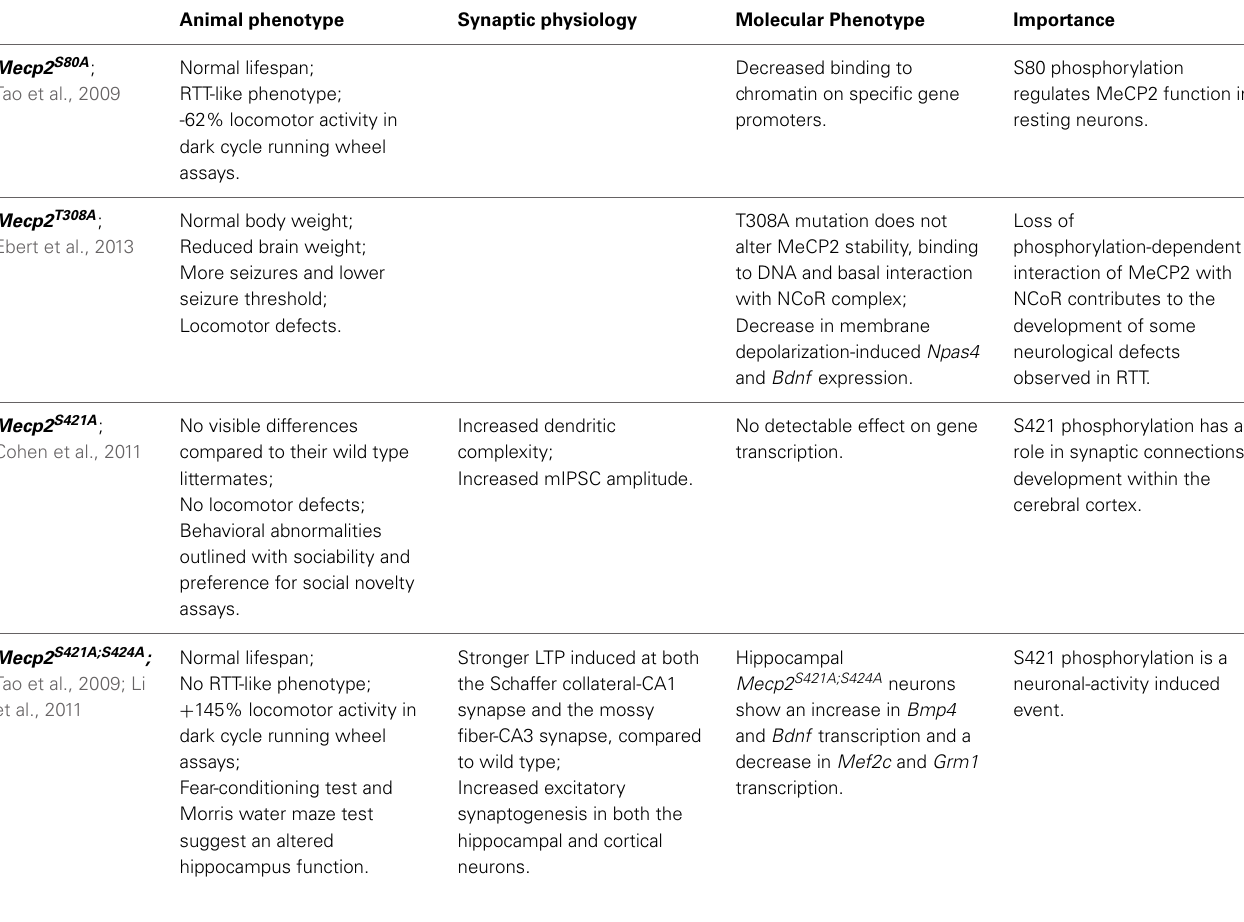
Table 1 | Phosphorylation-defective Mecp2 mouse